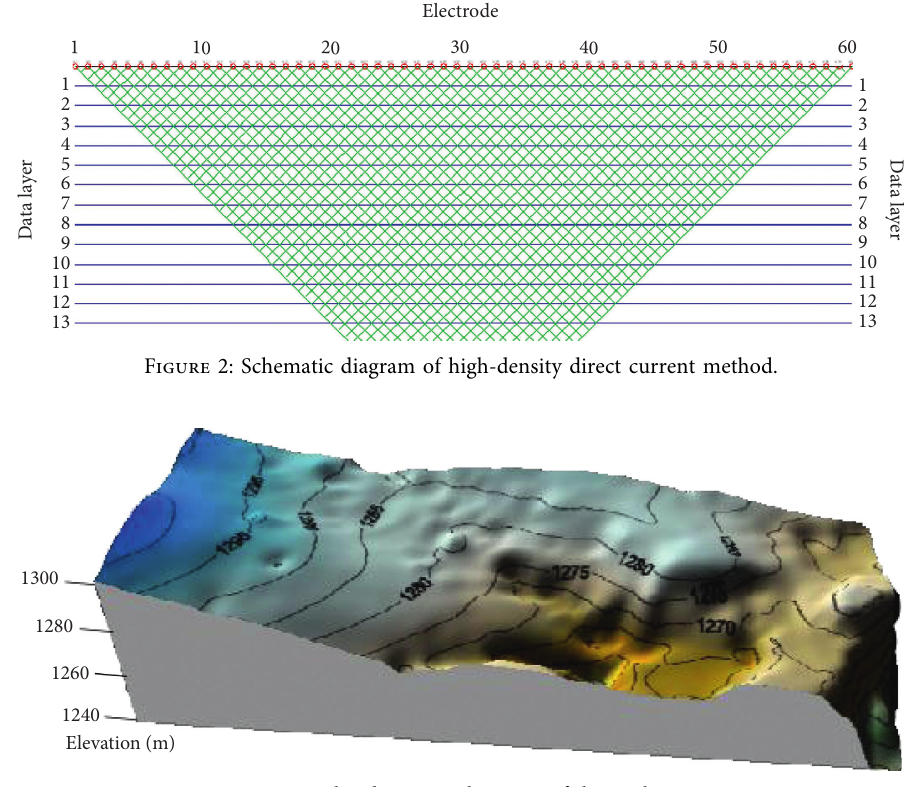
Figure 3: 3D simulated topographic map of the exploration